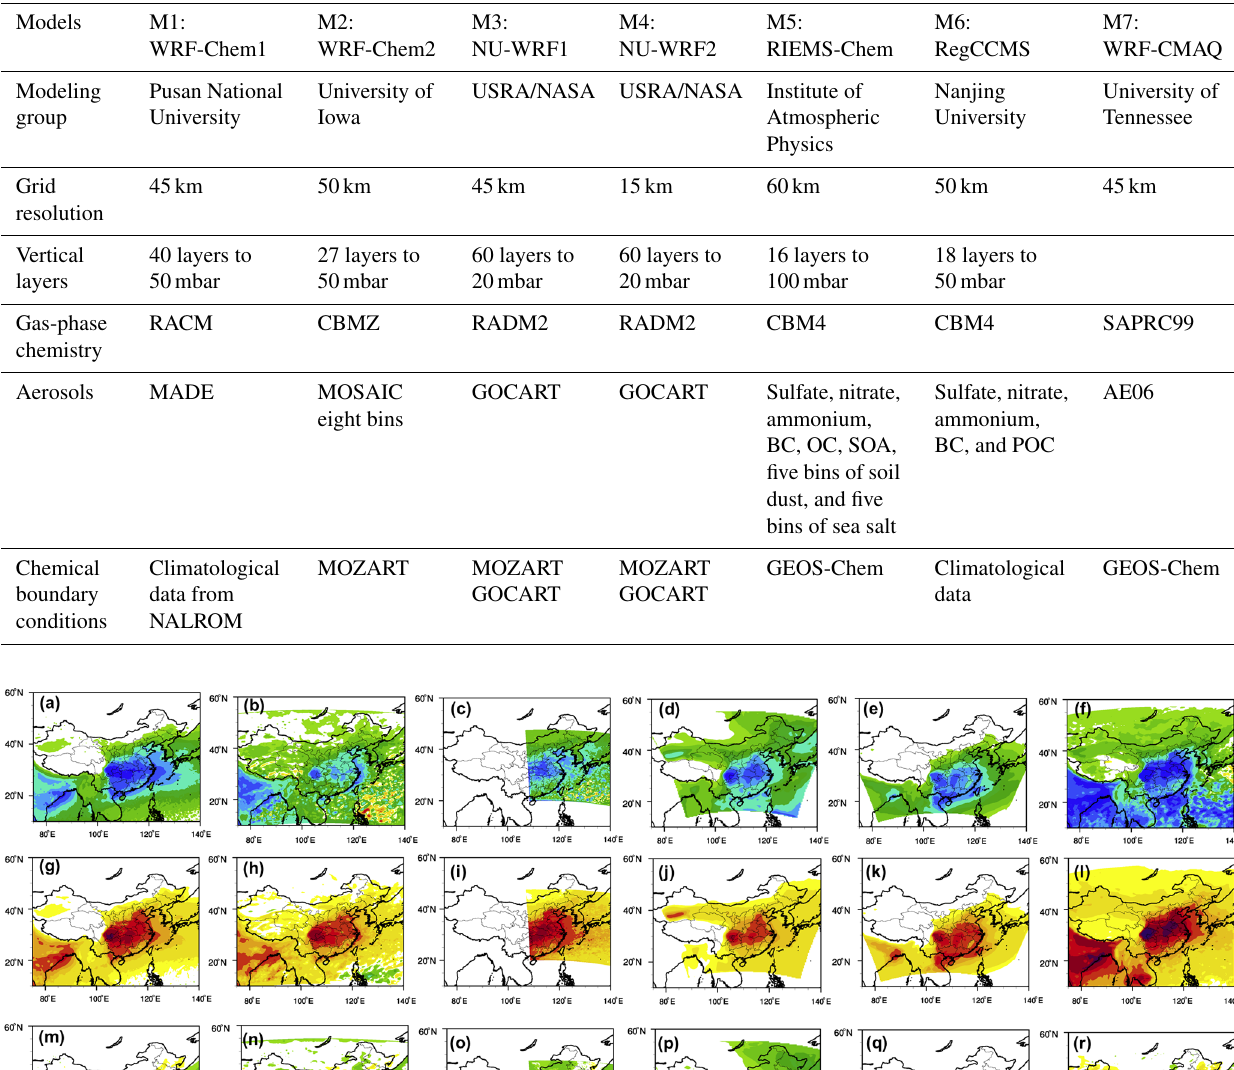
Table 1. Participating models in Topic 3. Models